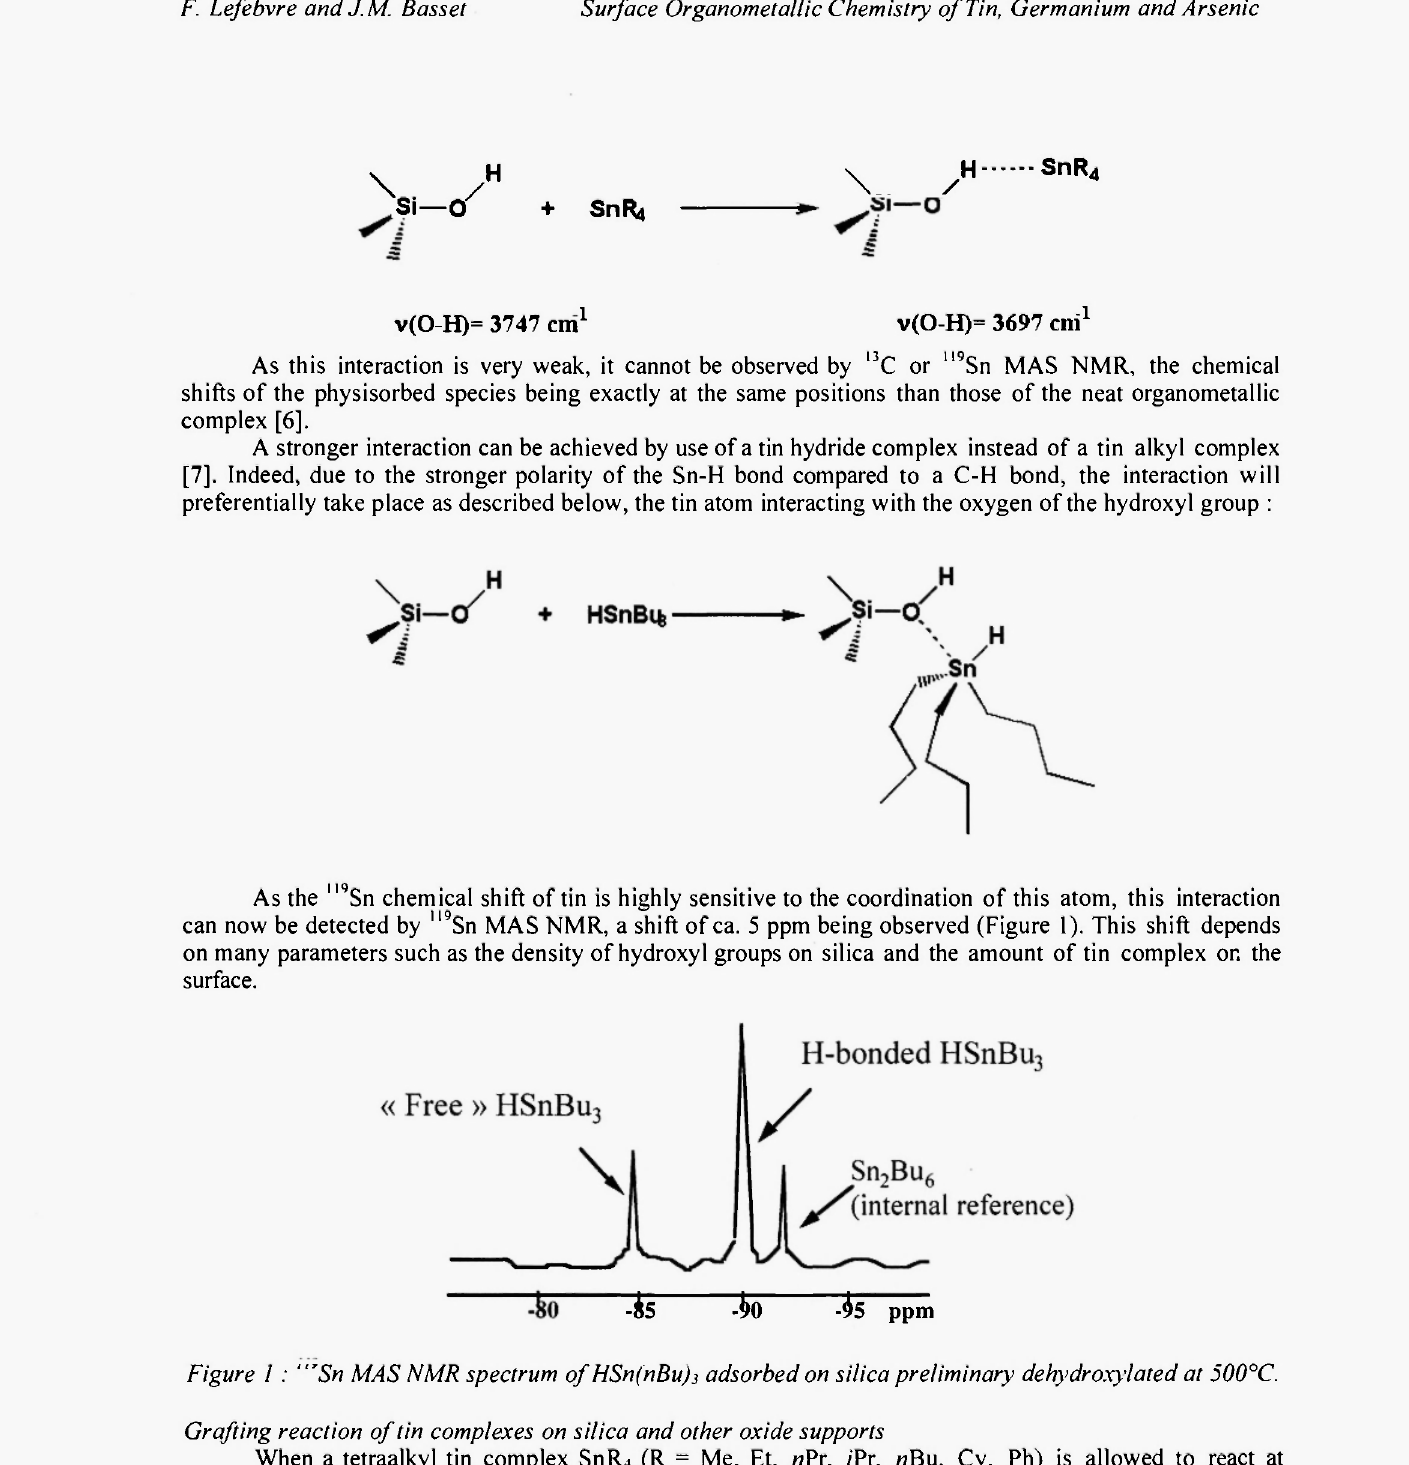
Figure I : Sn MAS NMR spectrum of HSn(nBu) 3 adsorbed on silica preliminary dehydroxylated at 500°C. Grafting reaction of tin complexes on silica and other oxide supports When a tetraalkyl tin complex SnR 4 (R = Me, Et, «Pr, /Pr, «Bu, Cy, Ph) is allowed to react